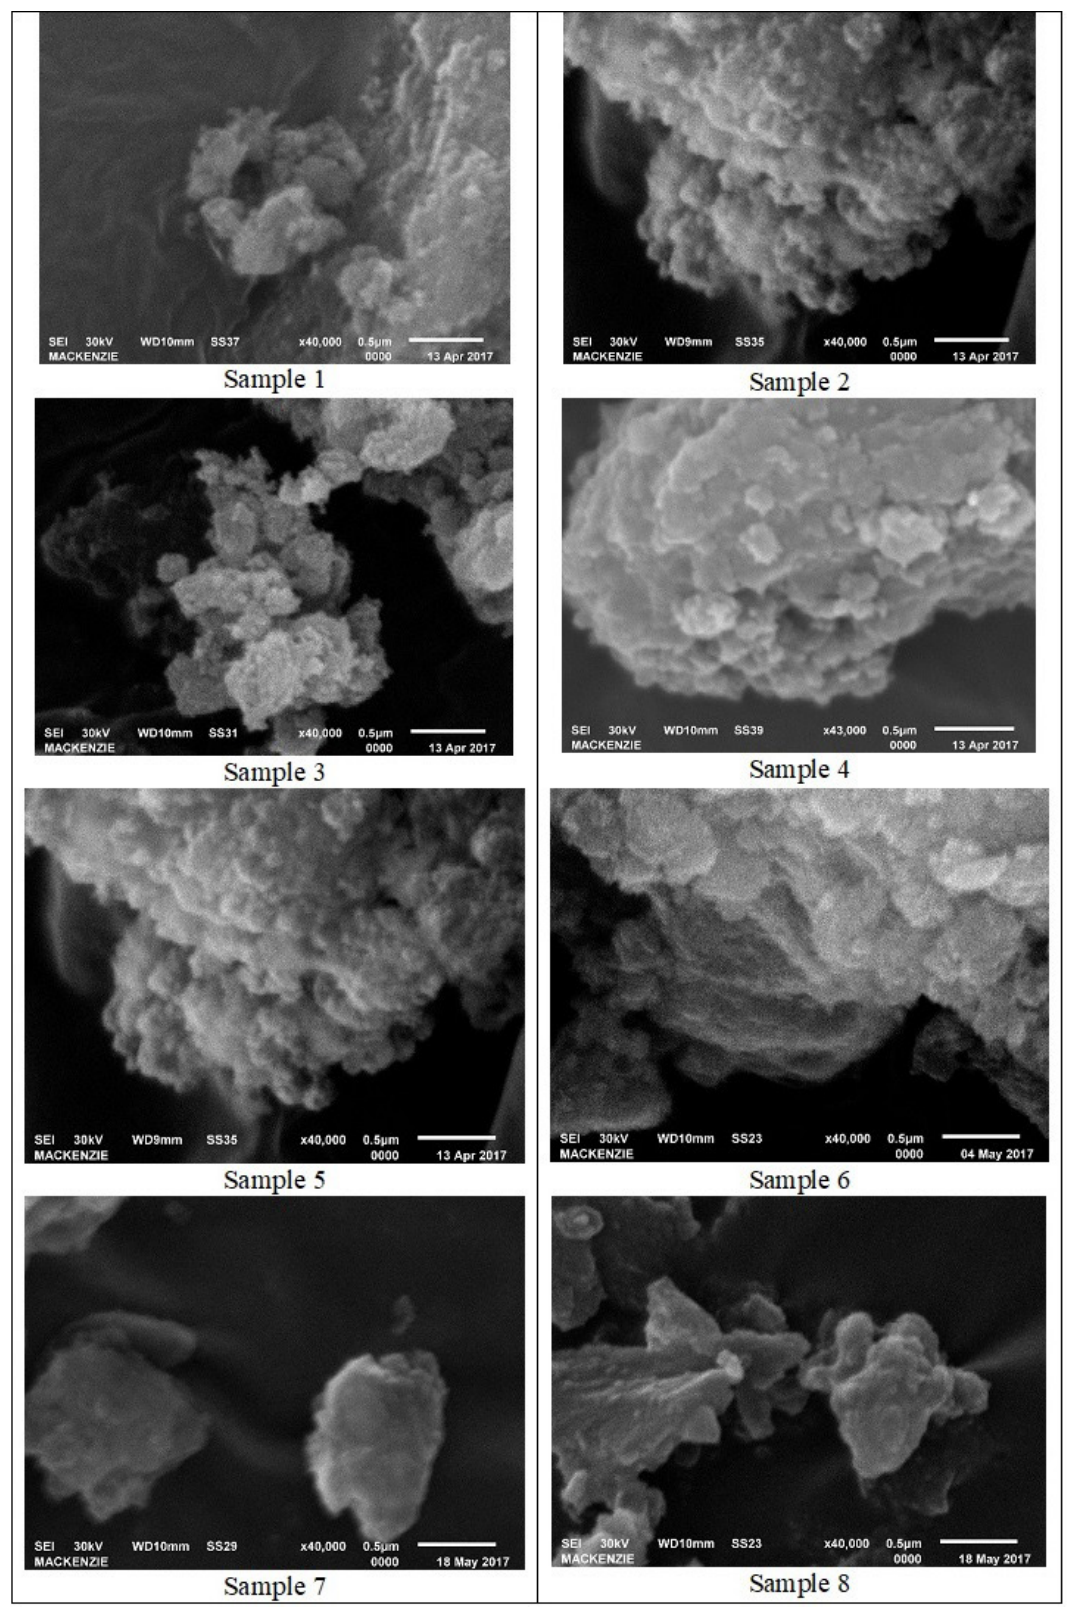
Figure 4. SEM of the samples 1 to